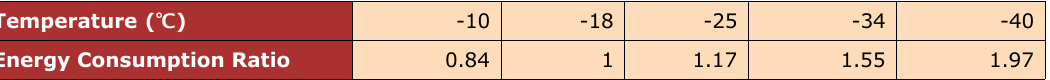
Table 4. Energy consumption ratio of refrigeration equipment under different temperature